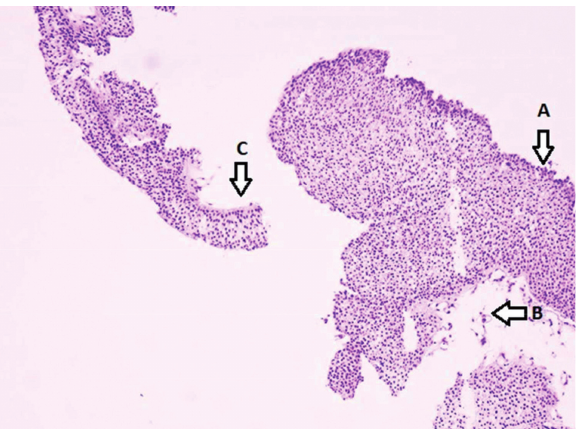
figure 3 - Epithelial hyperplasia (Arrow A), marked blade edema (Arrow B). compare with normal left fragment (Arrow c). HE